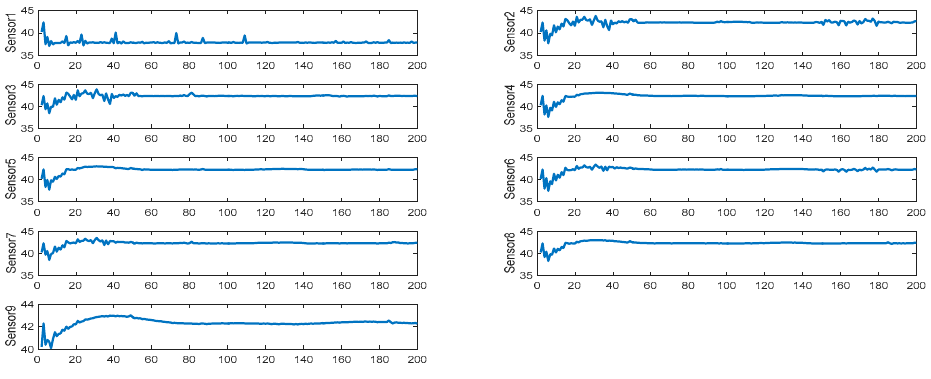
Figure 14. Simulation results of each sensor.